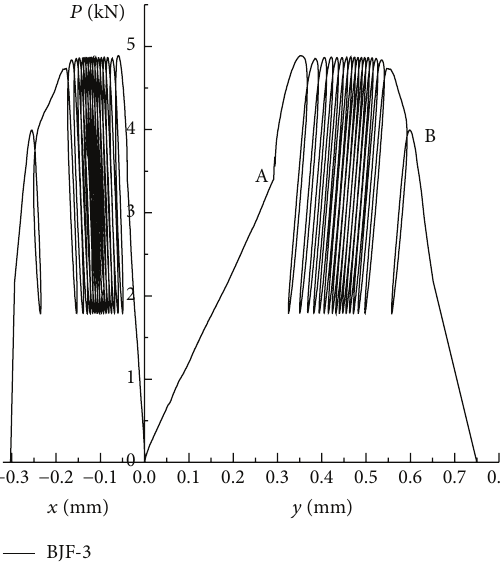
Figure 5: Load-deformation curves of Brazilian split fatigue tests of constant average